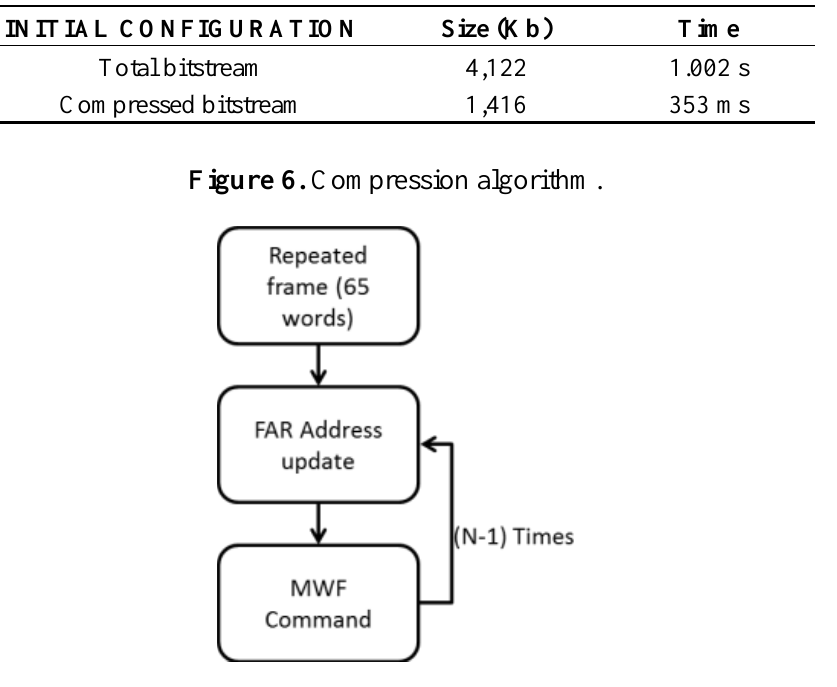
Table 2. Initial bitstream